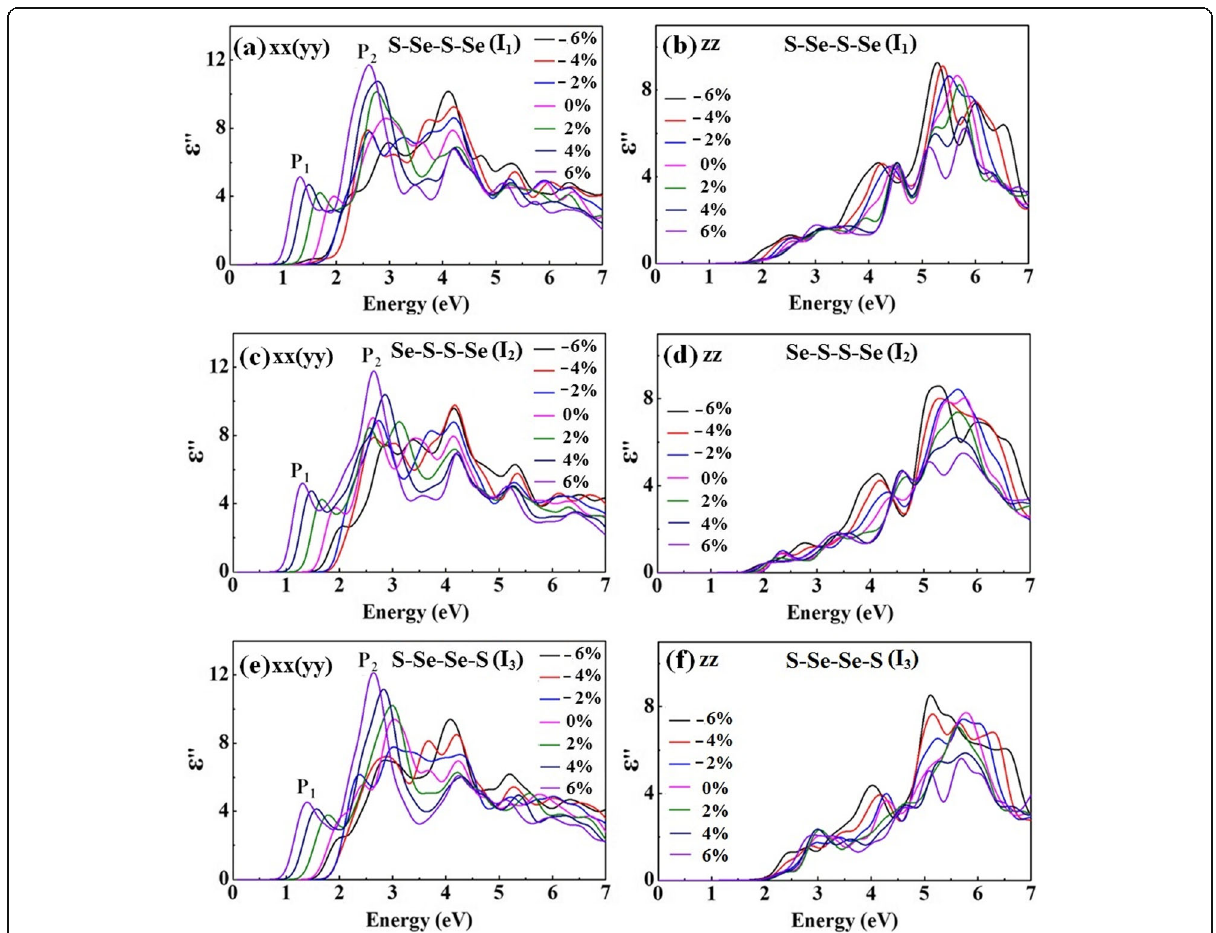
Fig. 8 The imaginary parts of calculated optical dielectric function ε ” xx ( ε ” yy ) and ε ” zz for I 1 ( a , b ), I 2 ( c , d ), and I 3 ( e , f ) WSSe bilayer versus the applied strain,